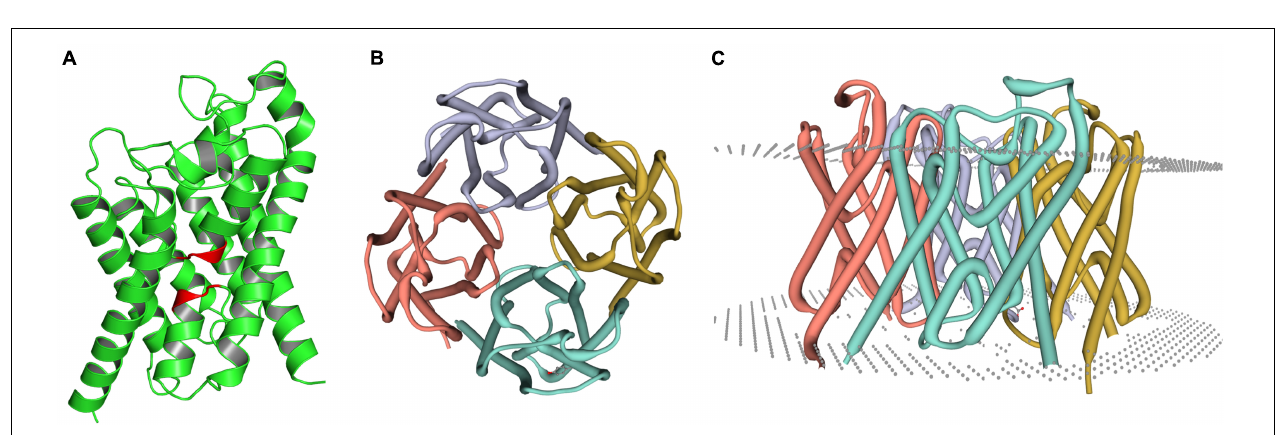
FIGURE 3 | Prediction of the structure of H. qinghaiensis AQP topology using the TMHMM server. The values indicate the amino acids forming part of each region. Abbreviation: Tmhelix, transmembrane helix.